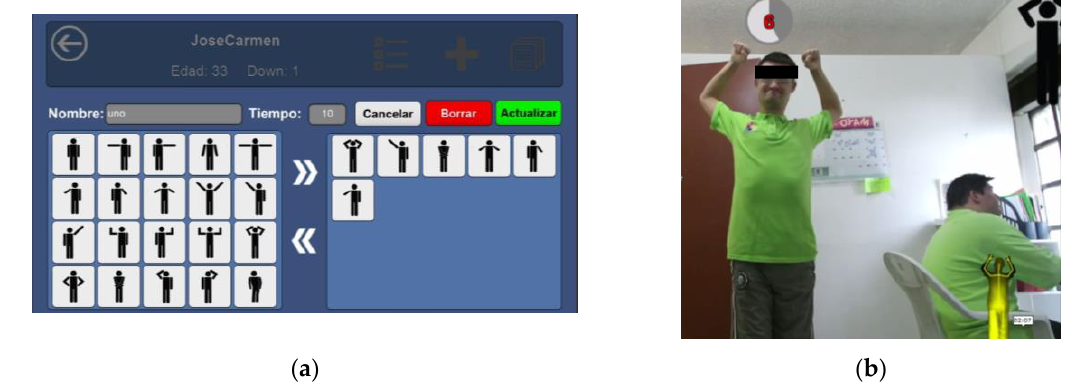
Figure 2. ( a ) Designing a Kinect routine; ( b ) Participant performing gesture 15 ‘Raise both hands to head’.